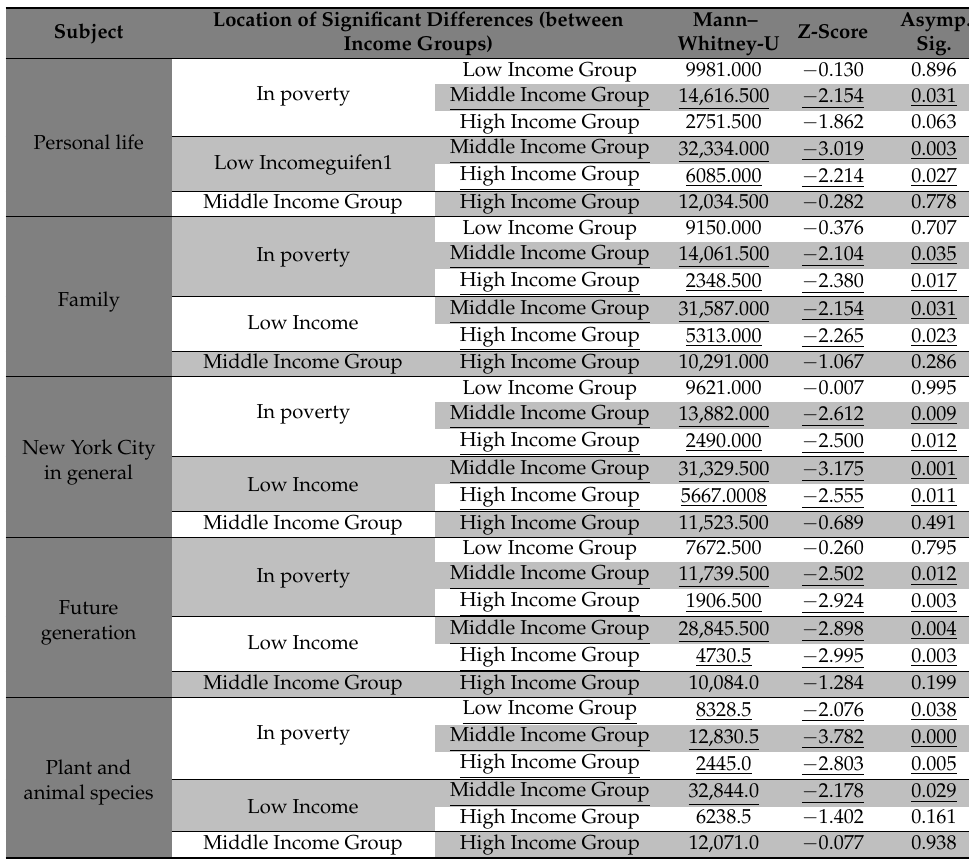
Table 3. Results of Mann–Whitney U-test regarding perceived extent of future impacts of heat waves. The underlined text shows the location of significant differences between income groups with p -values less than